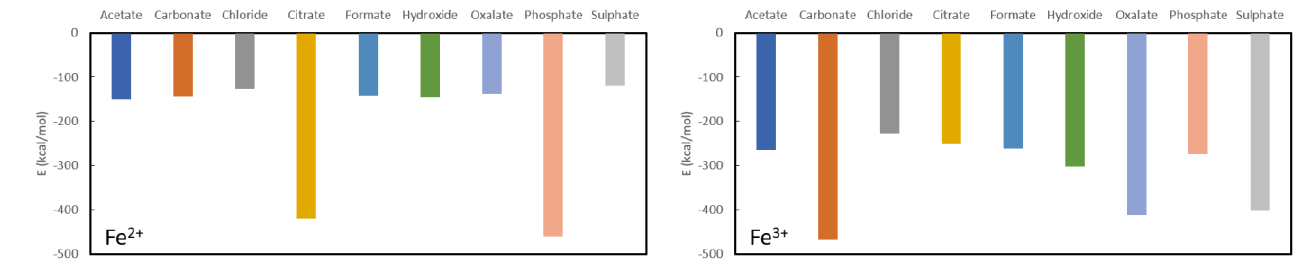
Figure 6. Formation energies for the complexes with Fe 2+ ( left ) and Fe 3+ ( right ).